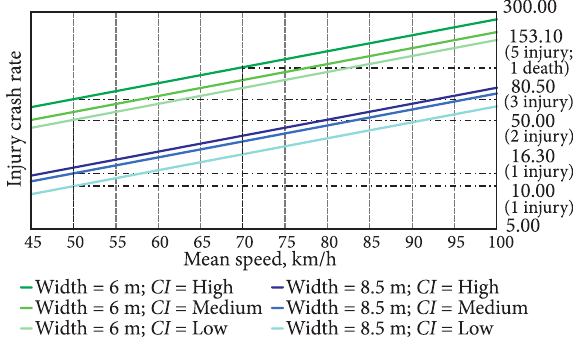
Fig. 2. Injury crash rates’ abacus for a crash type and